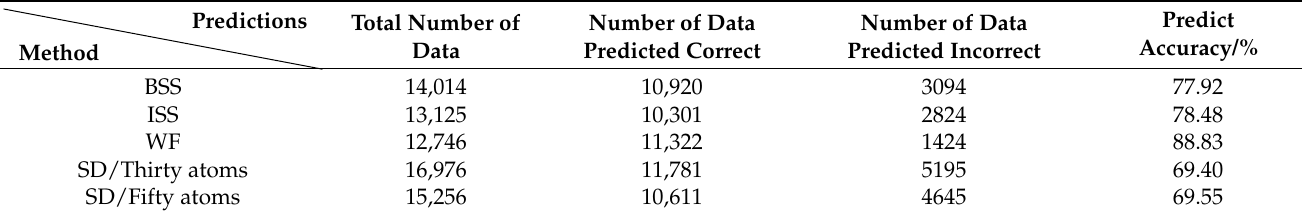
Table 4. Specific descriptions of the prediction results achieved by the kNN classifier on the five data sets.